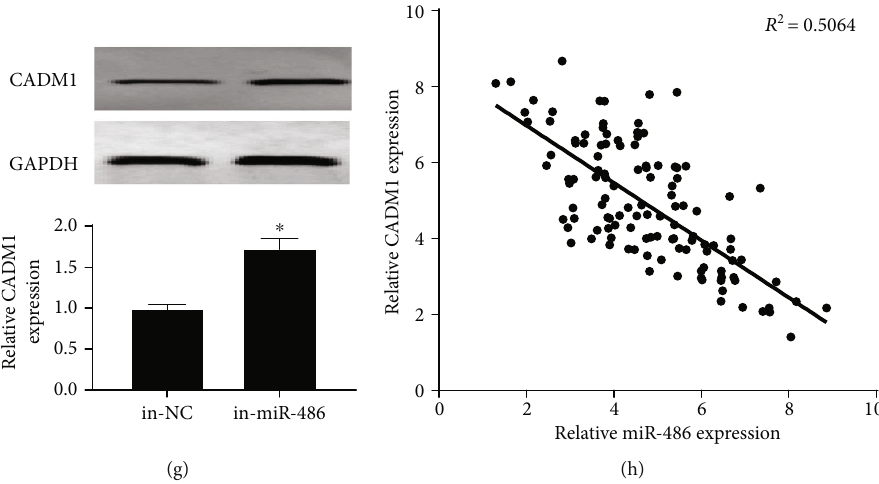
Figure 3: miR-486 targets CADM1. (a) Starbase V2.0 to predict the binding site between miR-486 and CAMD1; (b) dual-luciferase reporter assay to detect the targeting relationship between miR-486 and CADM1; (c) qRT-PCR assay to detect CADM1 expression in normal and OC tissues. CADM1 expression is low in OC tissues; (d) Western blot to detect the expression of CADM1 protein in normal and OC tissues; (e) qRT-PCR to detect the expression of CADM1 in SKOV3, Caov3, ES-2, OVCAR3, and IOSE80; (f) qRT-PCR to detect the expression of CADM1 mRNA in SKOV3 cells after transfection with miR-486 inhibitor; (g) Western blot to detect the expression of CADM1 protein in SKOV3 cells after transfection with miR-486 inhibitor; (h) Pearson analysis of the correlation between miR-486 and CADM1. ∗ P < 0 : 05 and ∗∗ P < 0 : 01